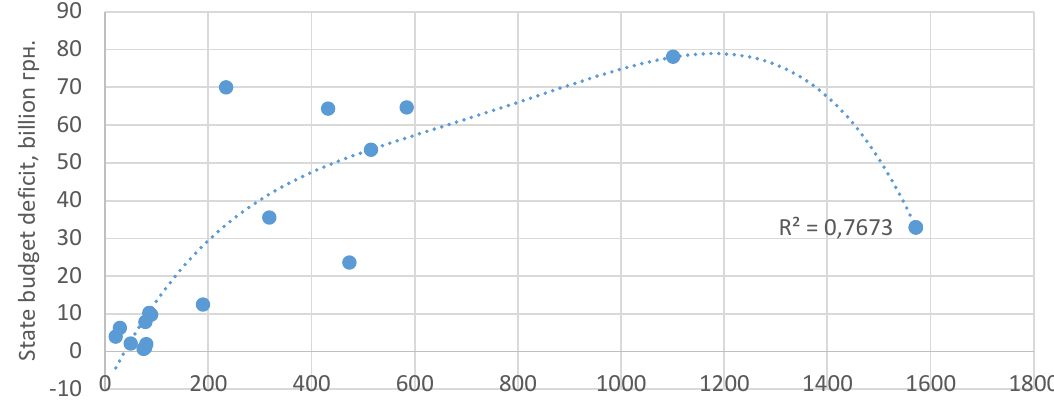
Figure 2. Dependence of the Ukraine’s state debt size on state budget deficit during